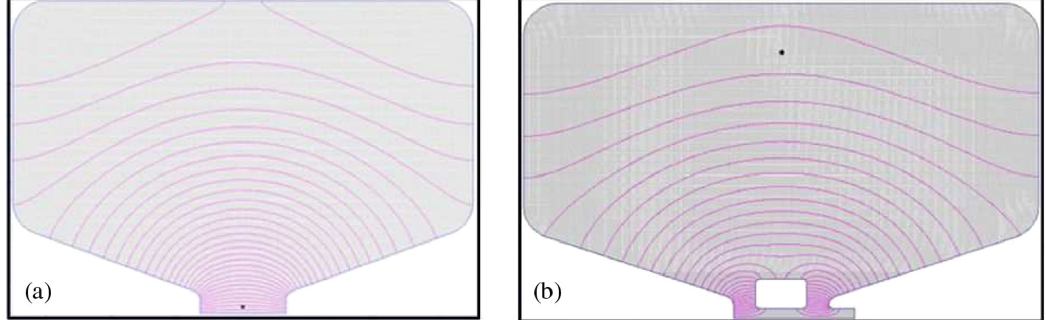
FIG. 3. Electric field distributions for two additional APEX-2 configuration options. (a) Single-cell with dual-reentrant nosecones. (b) Single cell with drift tube. The design field at the cathode for both configurations is ∼ 35 MV/m. See the text for more details.